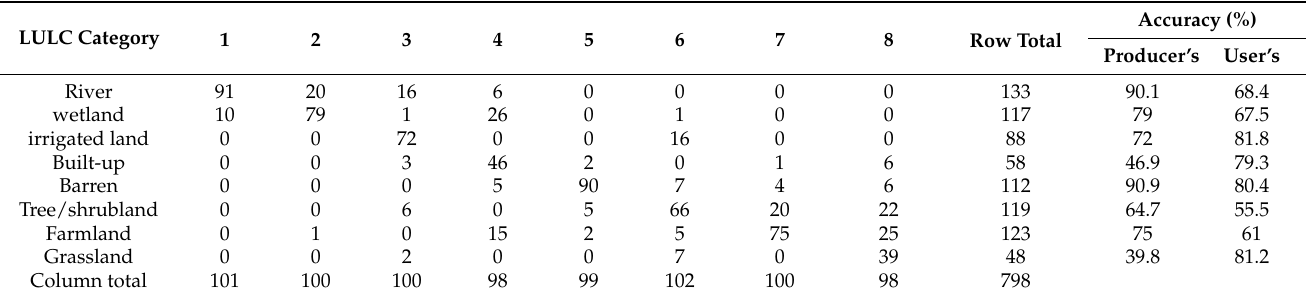
Table 6. Confusion matrix for Sentinel-2 accuracy assessment (Scenario 2) classification. Overall error